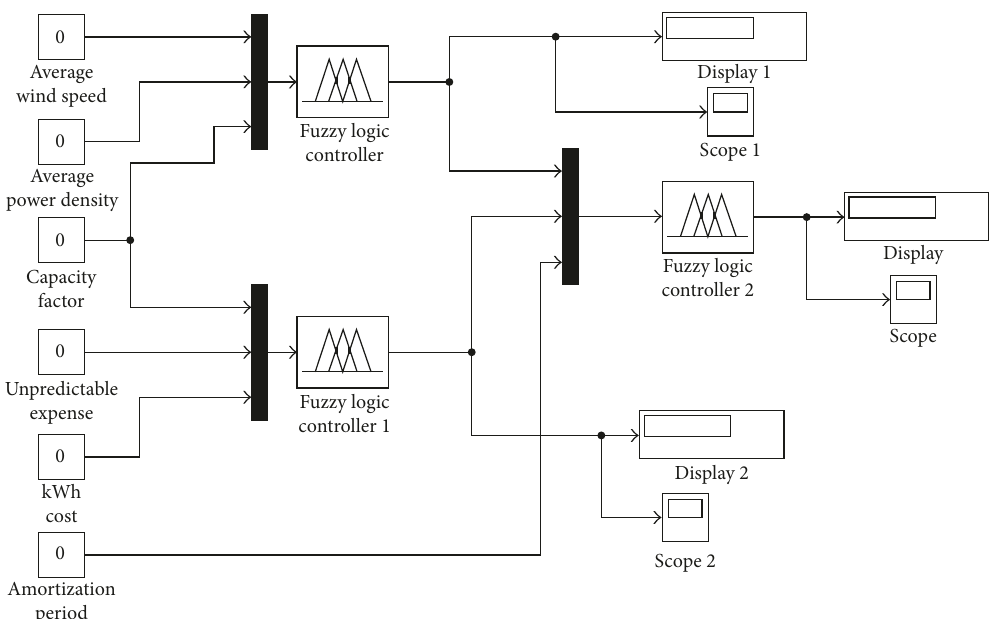
Figure 1: Matlab/Simulink model of the designed